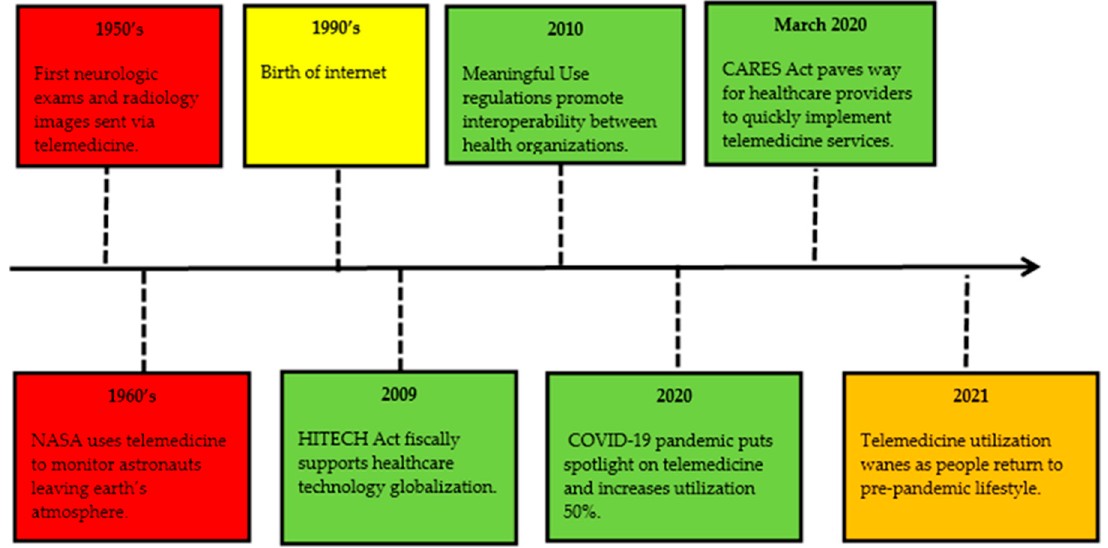
Figure 1. Timeline of telemedicine evolution.